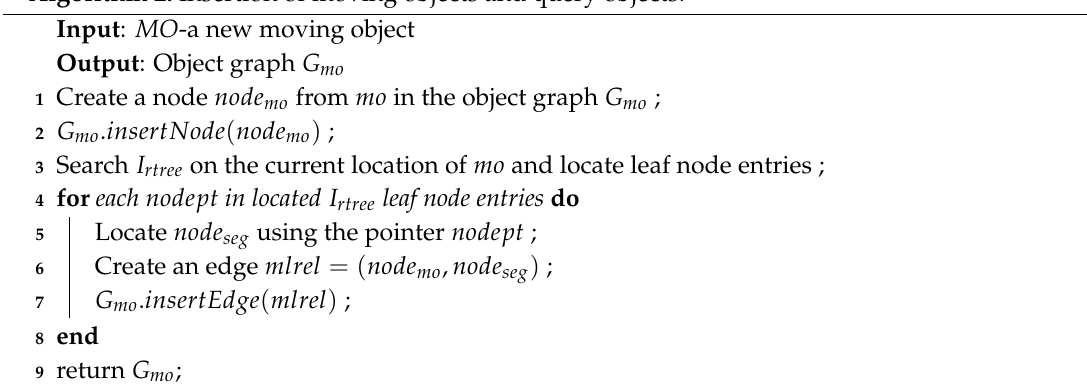
Algorithm 2: Insertion of moving objects and query objects.